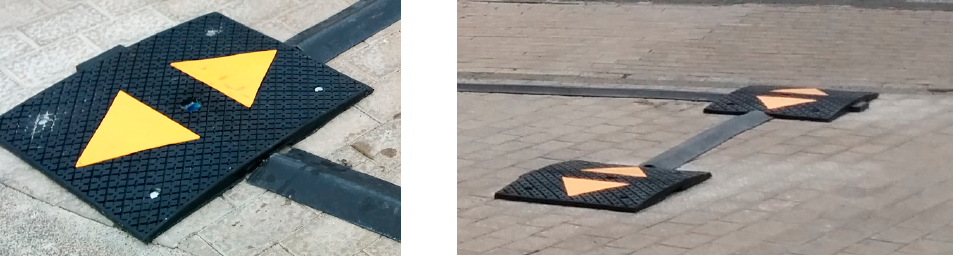
Figure 5. Installation of the sensors in two speed bumps ( left ) photoelectric sensor located at the centre of the speed bump; ( Right ) Pair of speed bumps with the photoelectric sensors.